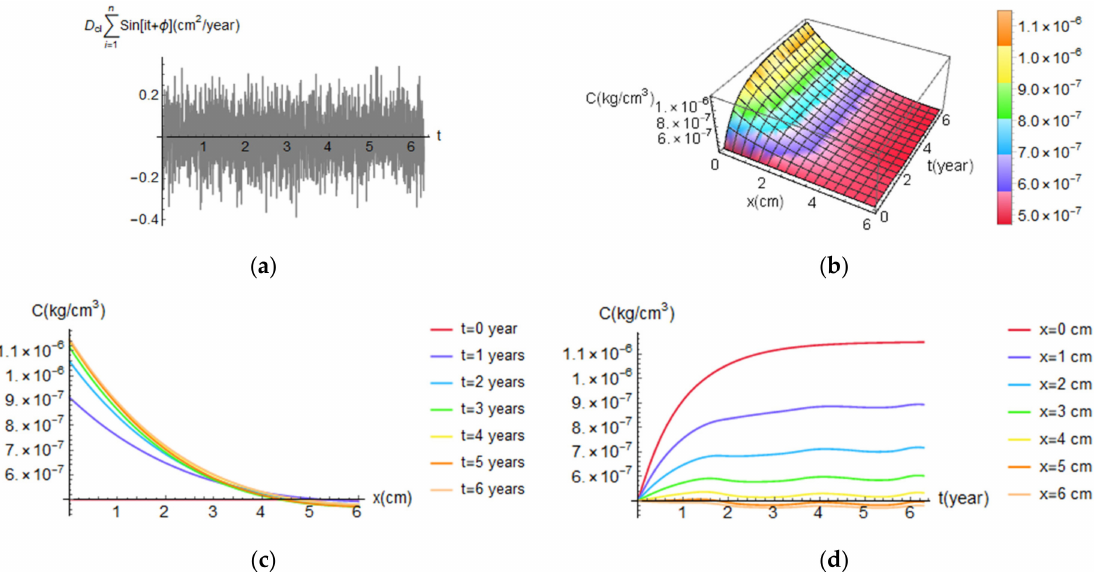
Figure 8. Numerical results for general f D (x,t): ( a ) its trend; ( b ) 2D complete results; ( c ) results in x domain; ( d ) results in t domain.